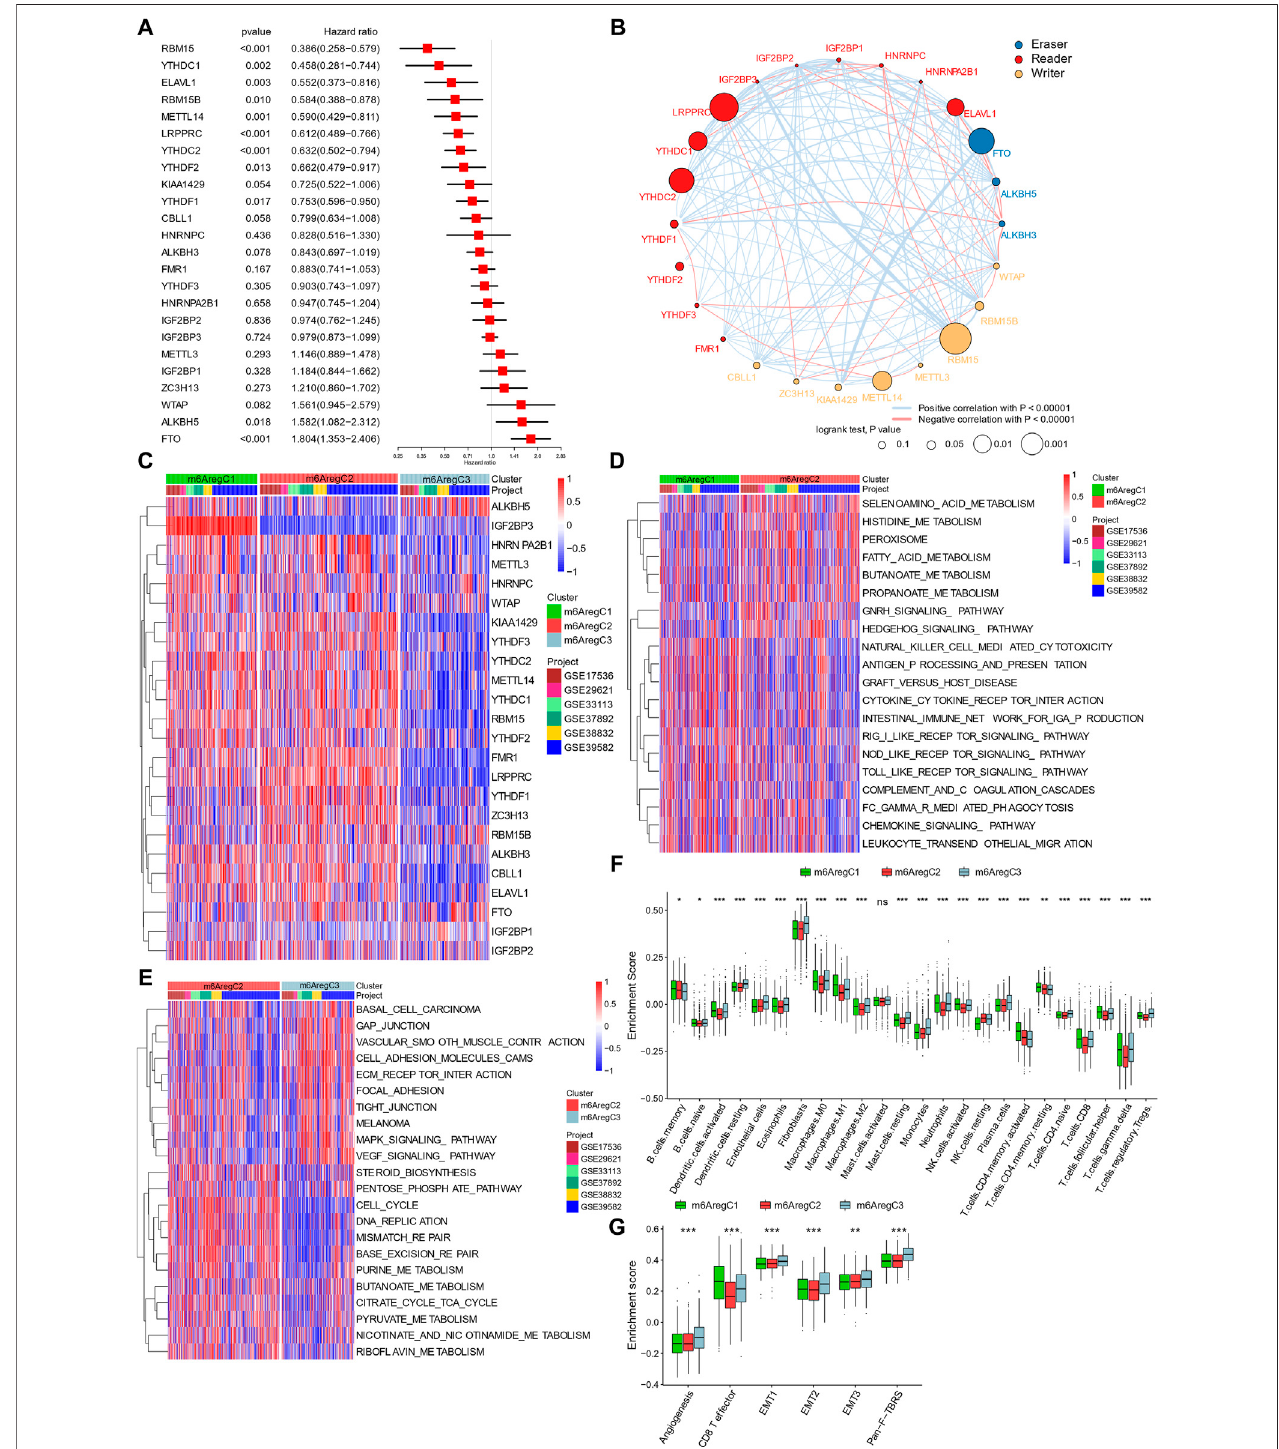
FIGURE 2 | Clustering of m 6 A regulator – based subtypes in meta-data of six Gene Expression Omnibus cohorts. (A) Hazard ratio of m 6 A regulators in predicting survivals in CRC patients. (B) Interaction among m 6 A regulators in colorectal cancer. Line colors represent positive or negative correlation, and thickness represents correlation strength. Colored circles indicate the types of m 6 A regulators, and circle sizes indicate prognostic ability. (C) Unsupervised clustering based on 24 m 6 A regulators. Three clusters, termed m 6 A reg C1 – 3, were de fi ned. (D – E) Differential biological pathways between m 6 A regulator – based clusters. The pathways were quanti fi ed by gene set variation analysis enrichment and compared between C1 and C2 (D) and C2 and C3 (E) . (F) Abundance of tumor-in fi ltrating cells in three subtypes. (G) Enrichment of stroma-activated pathways in three subtypes. One-way ANOVA tests compared the three groups in (F , G) . * p < 0.05; ** p < 0.01; *** p <